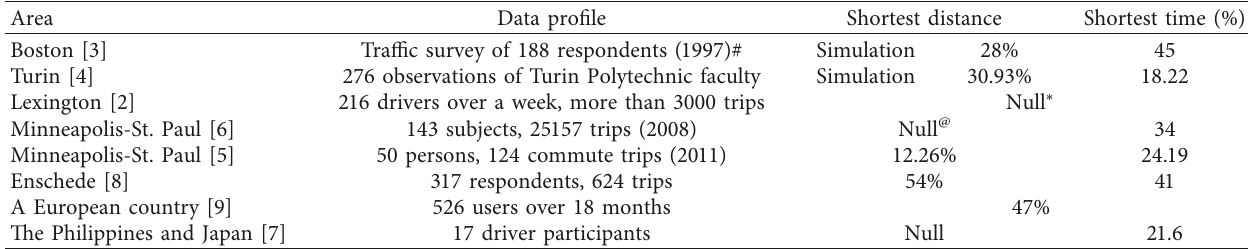
Table 1: The shortest path selection proportion in existing